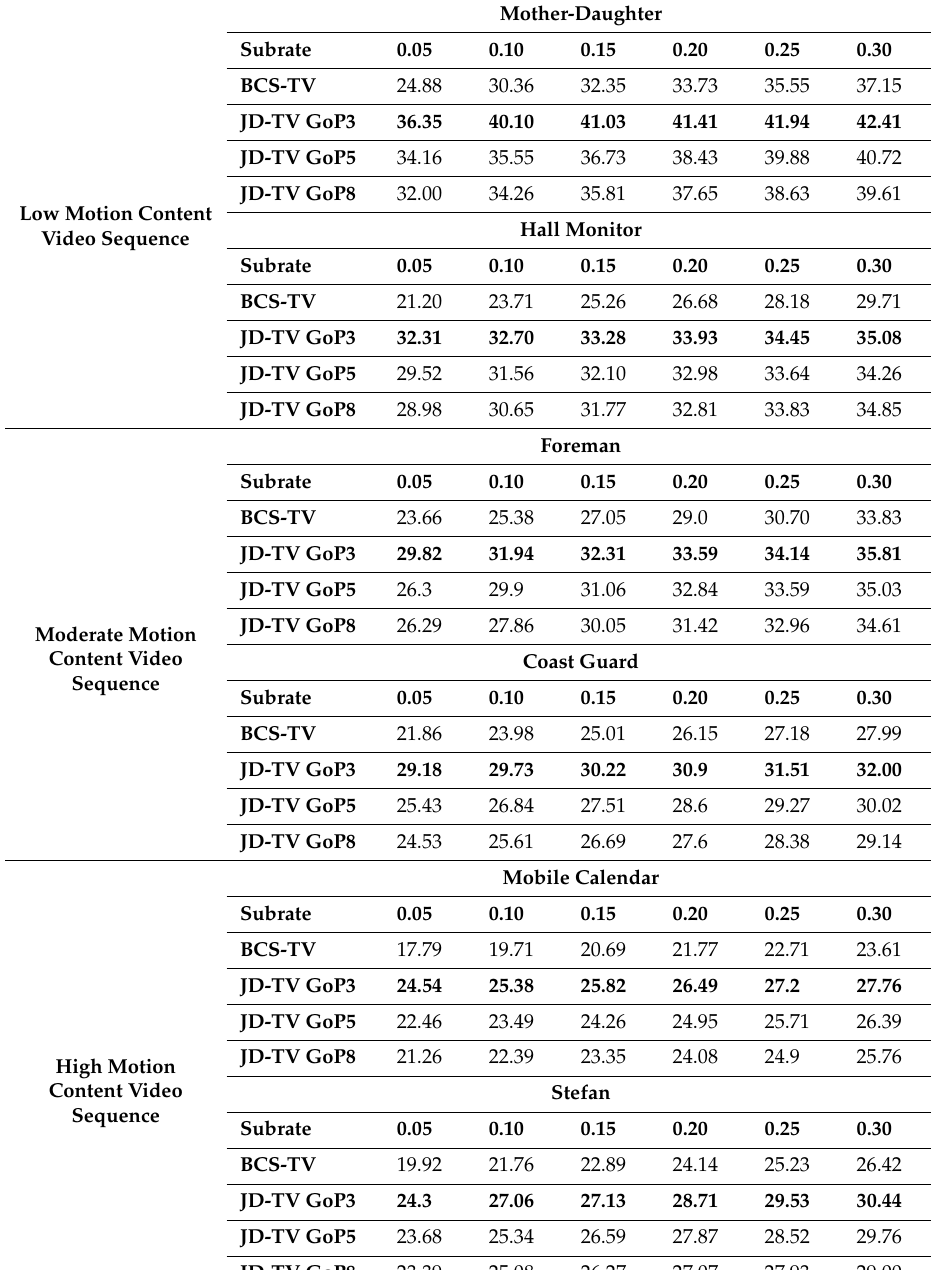
Table 3. Average PNSR evaluation of proposed JD-TV scheme and the independent BCS-TV-AL3 for di ff erent low, moderate, and high motion content video sequences at various